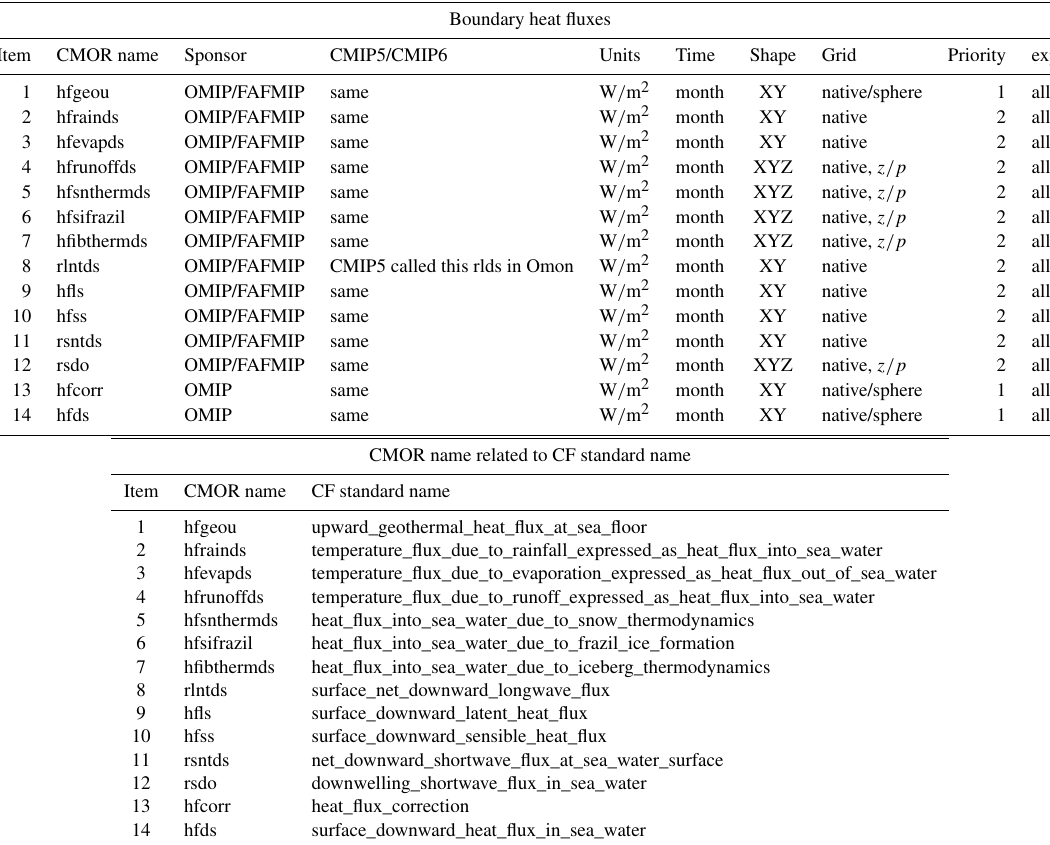
Table K3. This table provides a summary of the boundary fluxes of heat to be saved from the ocean component in CMIP6 simulations. Positive fluxes are into the ocean. The column indicating the experiment for saving the diagnostics generally says “all”, in which case we recommend the diagnostic be saved for CMIP6 experiments in which there is an ocean model component, including the DECK, historical simulations, FAFMIP, DAMIP, DCPP, ScenarioMIP, and C4MIP, as well as the ocean/sea-ice OMIP simulations. The Priority, = 1 diagnostics should be saved as decadal time means at decadal intervals for the piControl spin-up. For the geothermal heating, most models use a static geothermal heating, in which case only one time step need be archived. If time-dependent, then monthly fields are requested. Note that many climate models place boundary fluxes at the ocean surface. However, more general couplings are being considered (e.g. a sea ice or ice shelf model that interacts with more than the surface ocean cell). To allow for such generality, we note that many of the fluxes can be three-dimensional. Note that the field “rsdo” was mistakenly included in the CMIP5 diagnostic excel spreadsheet as “rsds”. Entries with grids denoted “native/sphere” denote diagnostics where native and spherical output are recommended to facilitate analysis (see discussion in Sect. A3). The lower sub-table relates the CMOR name to its CF standard